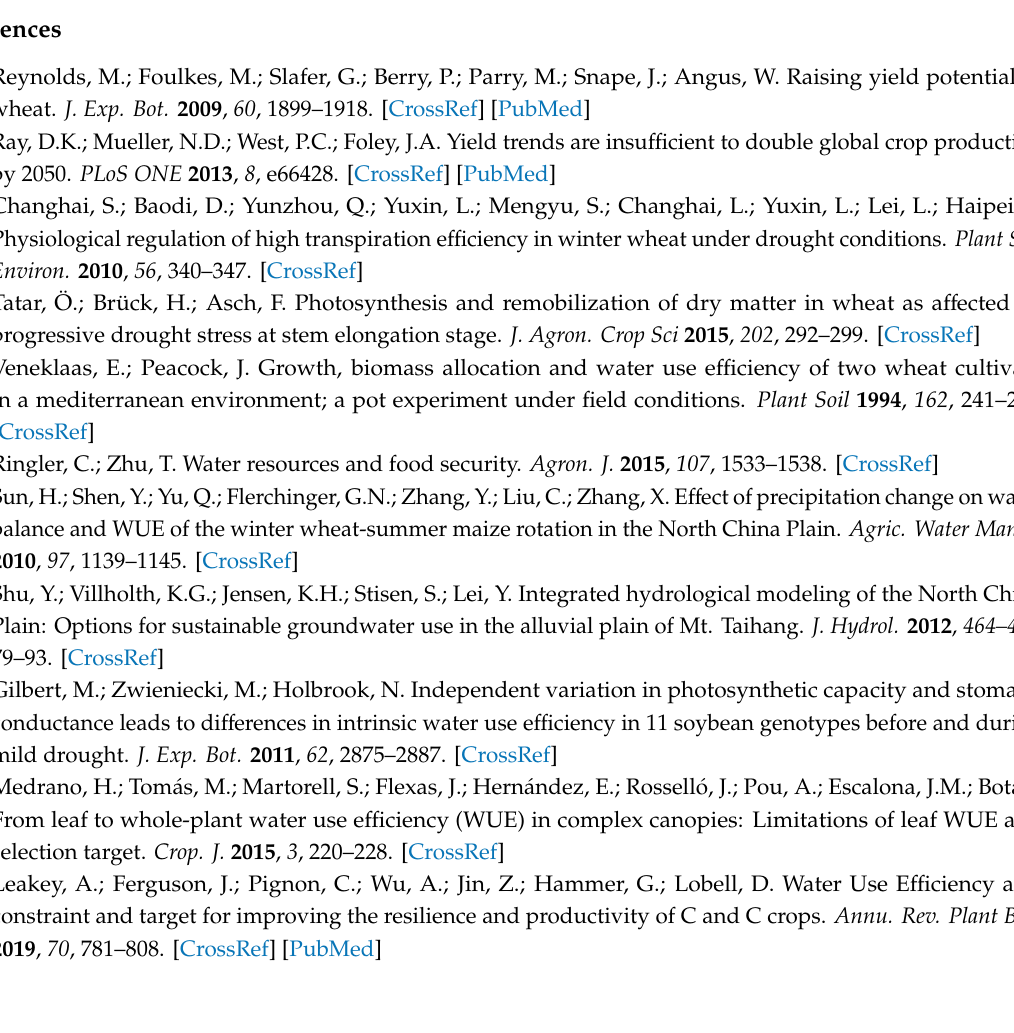
Table S1: Compiled Data, Figure S1: CO 2 assimilation × Rubisco Initial Activity, Figure S2: CO 2 assimilation × Rubisco Total Activity, Figure S3: Gravimetric water content × leaf age, Figure S4: ABA concentration × gravimetric water content, Figure S5: Stomatal conductance × Gravimetric water content, Figure S6: Stomatal Conductance × ABA content, Figure S7: Abscisic acid × leaf